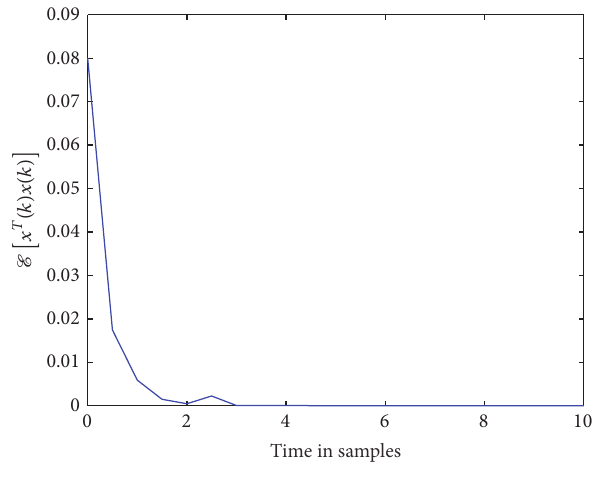
Figure 2: The curve of E {𝑥 𝑇 (𝑘)𝑥(𝑘)} .